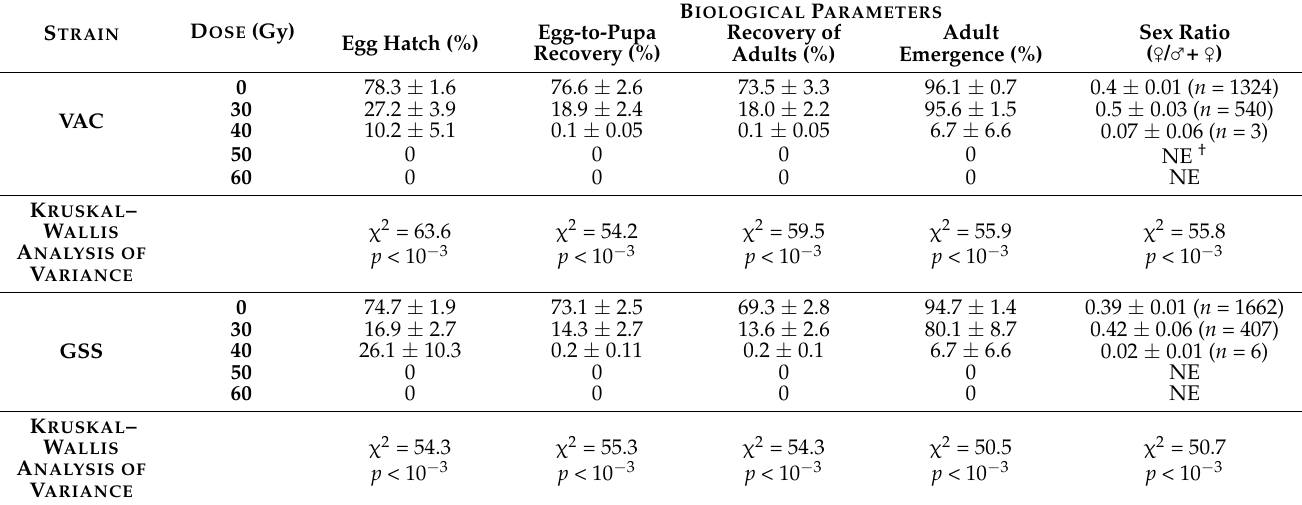
Table 4. Biological parameters (mean ± SE) from crosses between fertile male Anastrepha fraterculus from a bisexual strain (VAC) and females irradiated under hypoxia from the same strain and a genetic sexing strain (GSS). Total numbers of scored adults are in